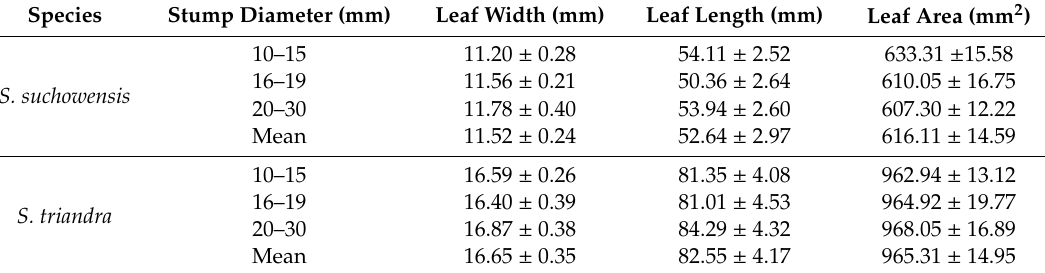
Table 4. E ff ect of stump diameter on leaf traits.